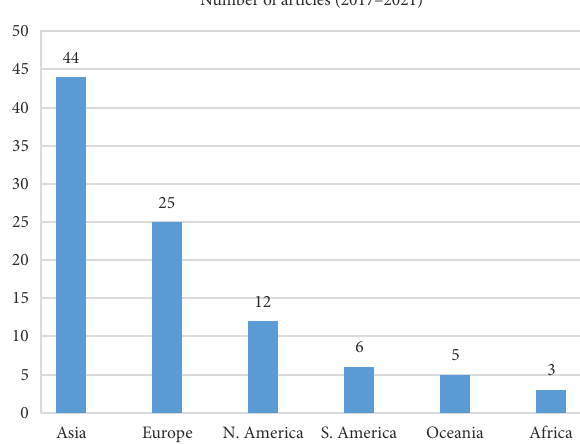
Figure 4. Number of articles from each continent